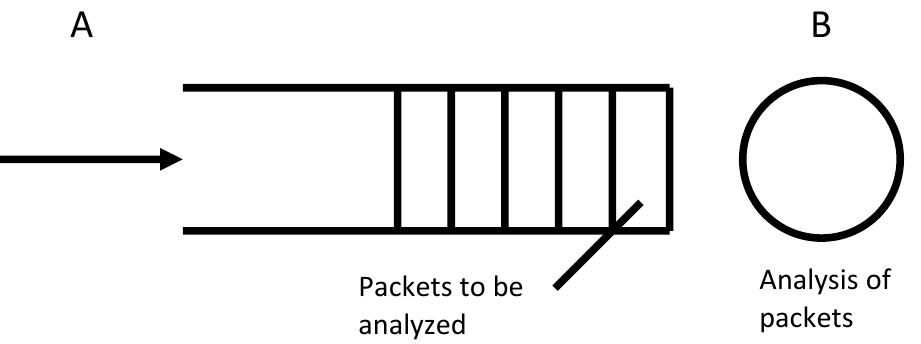
Figure 2. Visualization of queuing model to quantify the monitoring load for the presented predic- tion